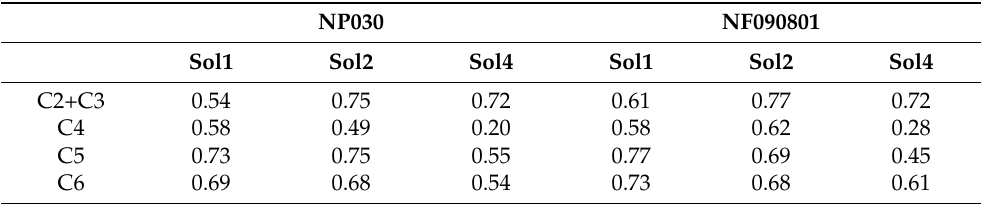
Figure 9. γ retention of ( a ) NP030 and ( b ) NF090801 with various feed solutions at 40 °C. The applied pressure values were 35, 30, 25, and 20 bar, respectively. Table 4. Dependence of the retention of hydroxy acids on their chain length as measured in various solutions.